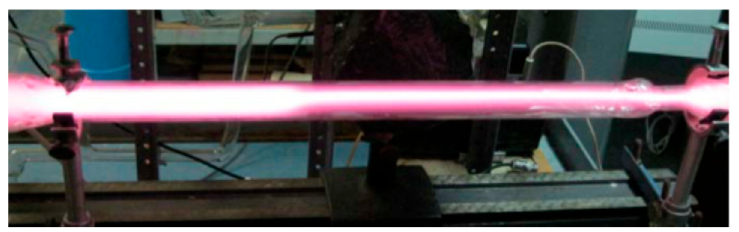
Figure 12. Steady-state partially constricted glow discharge in the Ar + 0.075% N 2 mixture, P = 40 Torr [19] (© 2011 IEEE).